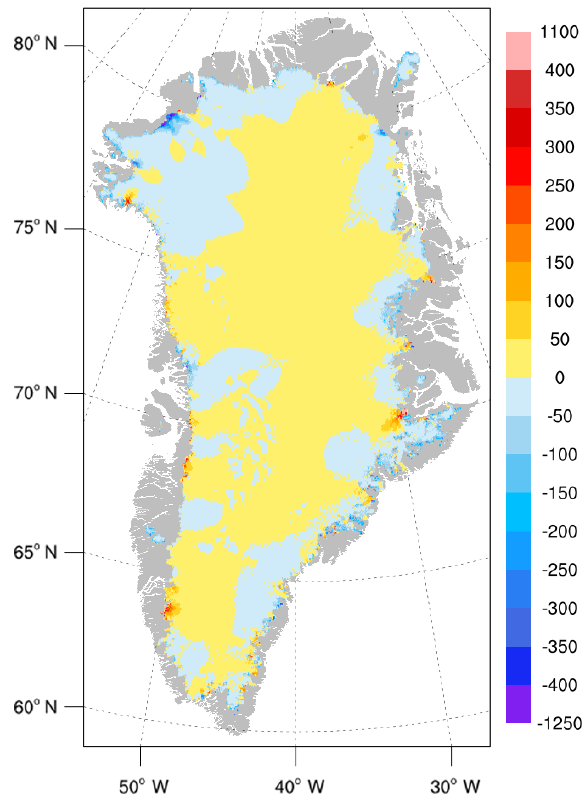
Figure 14. Difference (myr − 1 ) in simulated ice speed after 10kyr between (1) a run using the BP velocity solver and (2) a run using the DIVA velocity solver and otherwise configured identically. The gray background shows regions that are ice-free in both